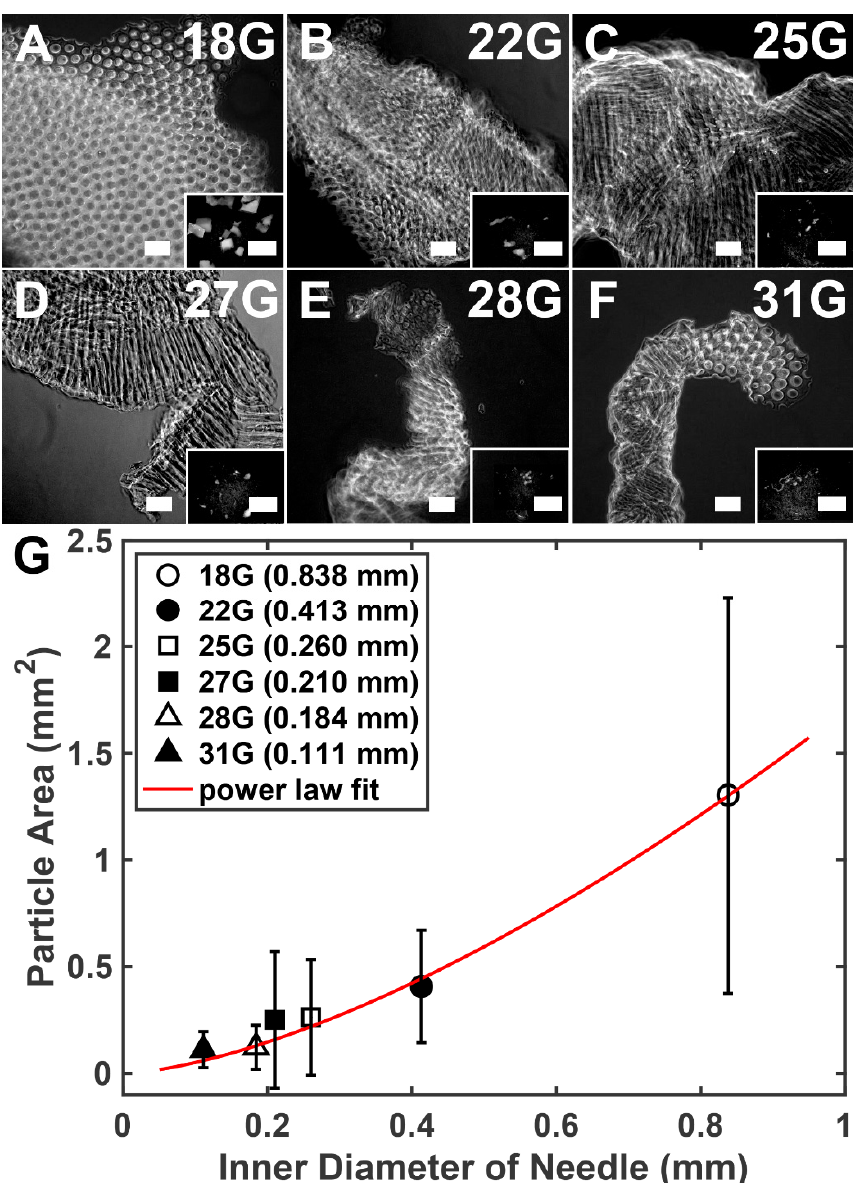
Figure 3. Sizes (areas) of sheared Capgel microparticles from extrusions using a range of different gauge needles follow a power-law relationship. ( A – F ) Phase-contrast micrographs of sheared Capgel microparticles formed during needle extrusions; the needle gauge used for each is indicated in the upper right of each panel. Insets show representative stereomicrographs of multiple sheared Capgel microparticles resulting from extrusion through each corresponding needle gauge; ( G ) plot of average microparticle areas (i.e., sizes) of extruded Capgel microparticles as a function of needle inner diameters (i.e, gauges). Scale bar = 100 µ m for ( A – F ) and 1 mm for all insets; error bars = SD in ( G